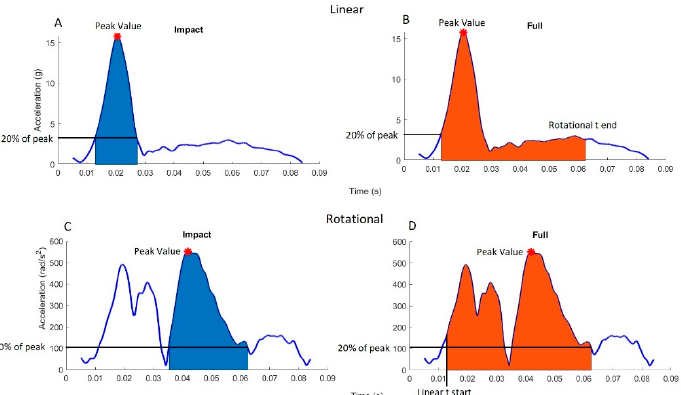
Figure 2. Time periods considered for the RMS calculations, with Impact ( A , C ) defining a threshold of 20% of the peak on either side of the peak, and Full ( B , D ) defining the same time duration for both based on linear and rotational 20% thresholds. Table 1. Drop heights (m) and foam combination (A–L) (Appendix A and B) for each impact sce- nario tested. Those unable to be tested are left blank. PLA (g)